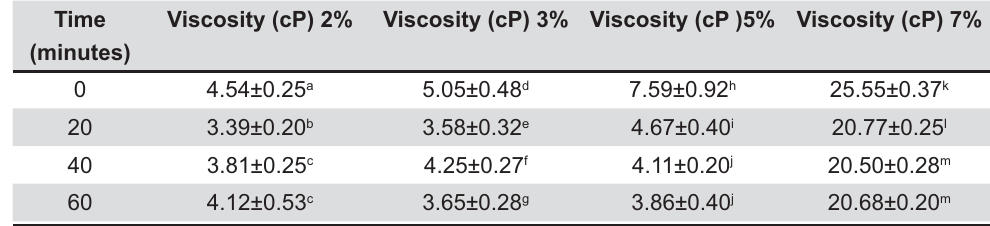
Table 3- Effect of time on the viscosity of untreated human milk thickened maintained at 37°C